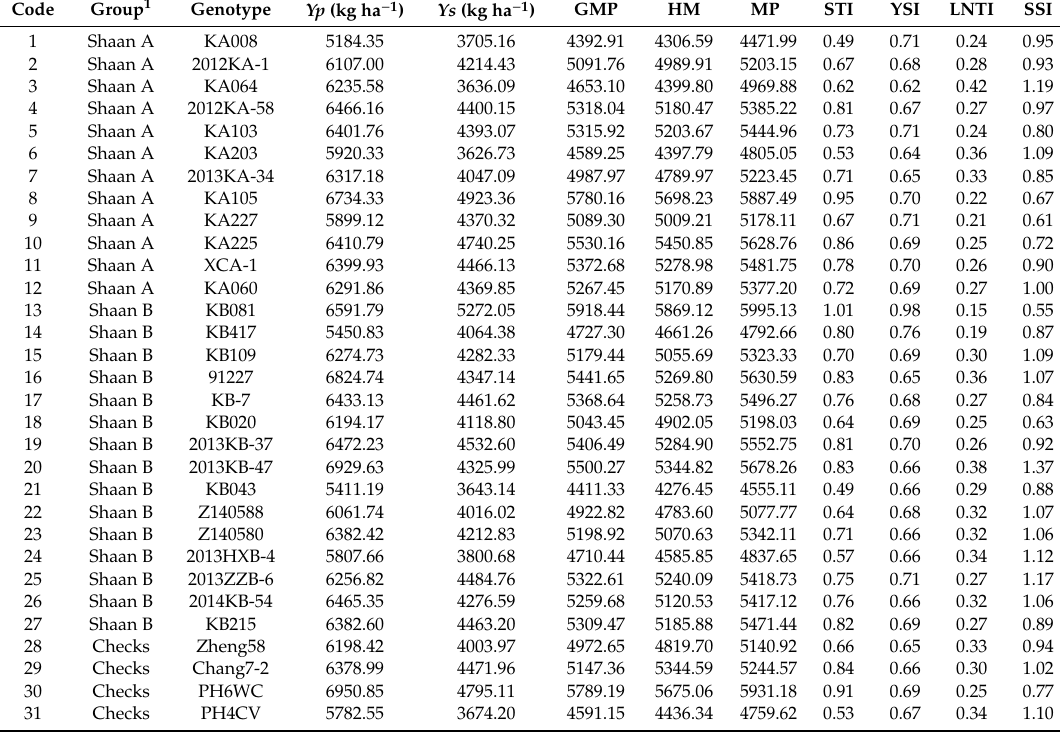
Table 1. Best linear unbiased prediction (BLUP) value for grain yield under high nitrogen (HN) ( Yp ) and low nitrogen (LN) ( Ys ) and seven screening index values for 31 inbred